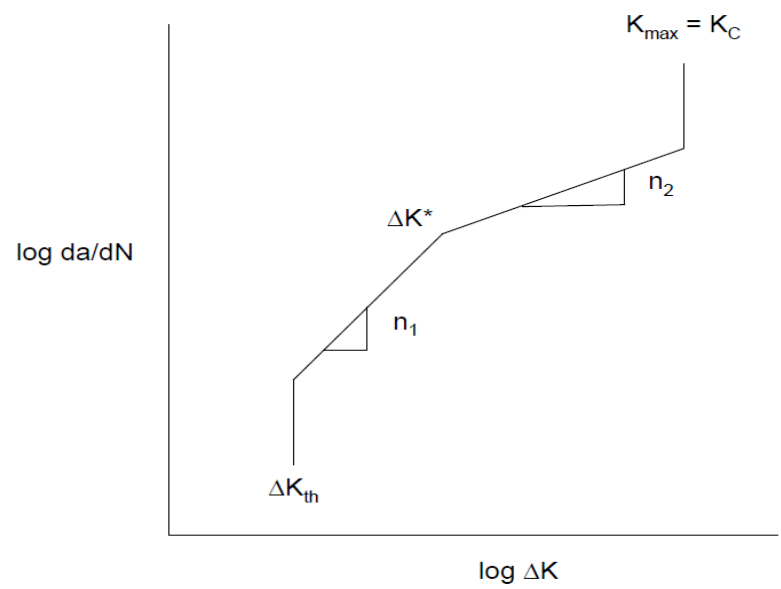
Figure 2. Bilinear FCG behavior [19].